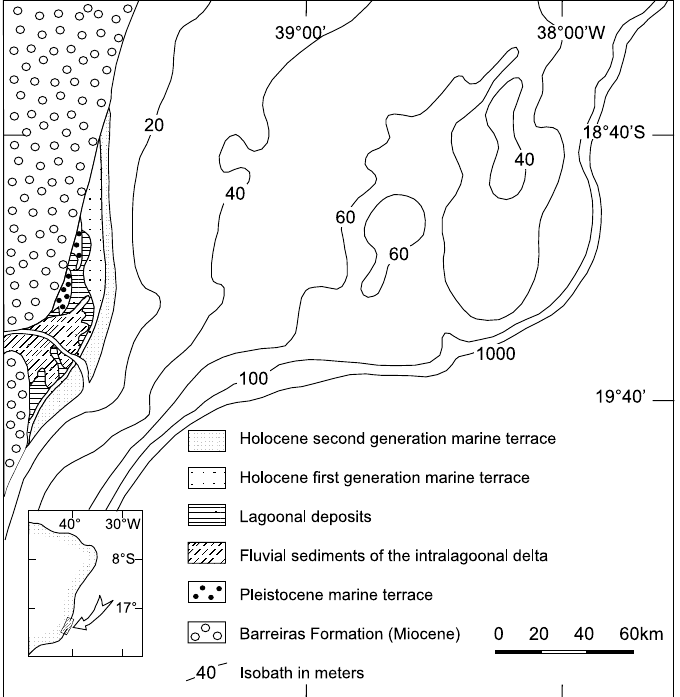
Fig. 1 – Schematic geological map of the coastal plain associated to Doce River mouth and morphology of the continental